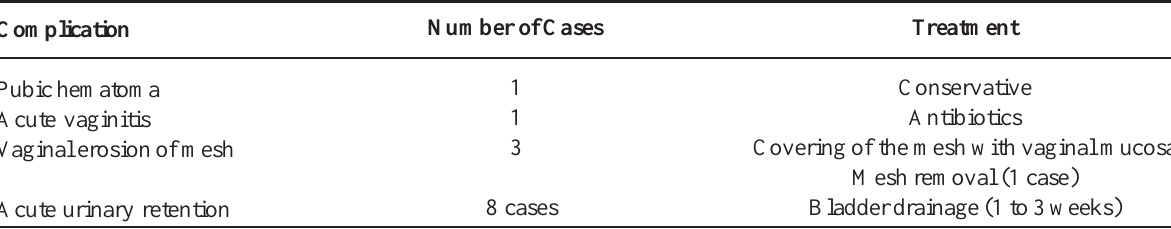
Table 2 – Postoperative complications and